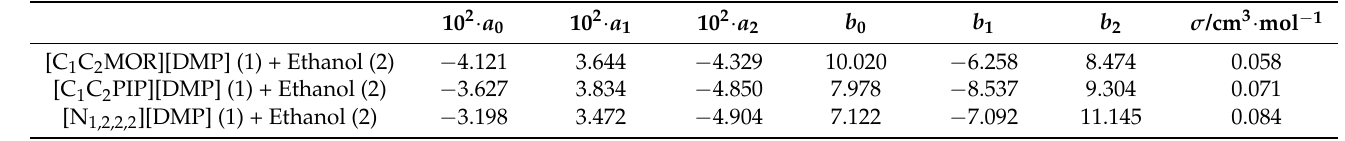
Table 11. Parameters for the Redlich–Kister Equation Using for the Correlation of the Excess Molar Volumes, V E for the {IL (1) + Ethanol (2)} Binary System. Along With the Standard Deviations, σ a